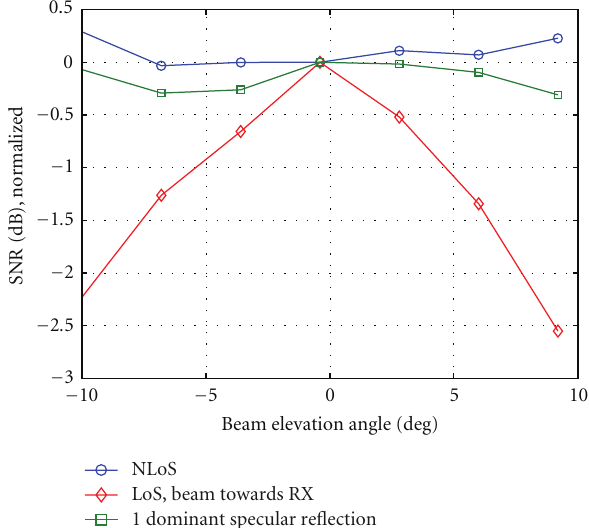
Figure 6: E b /N 0 along the line-of-sight path, without receiver diversity (no MRC) for − 10 ◦ , 0 ◦ , and +10 ◦ beams and for the space- time code. Labels on top indicate locations on the floor